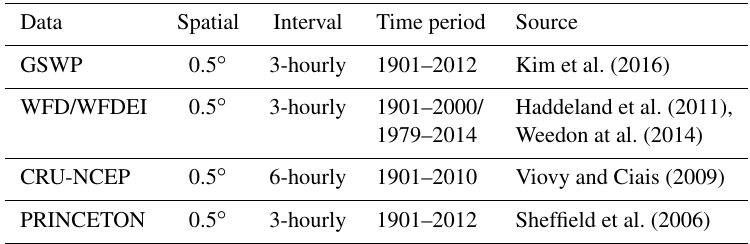
Table 1. General information on the meteorological forcing